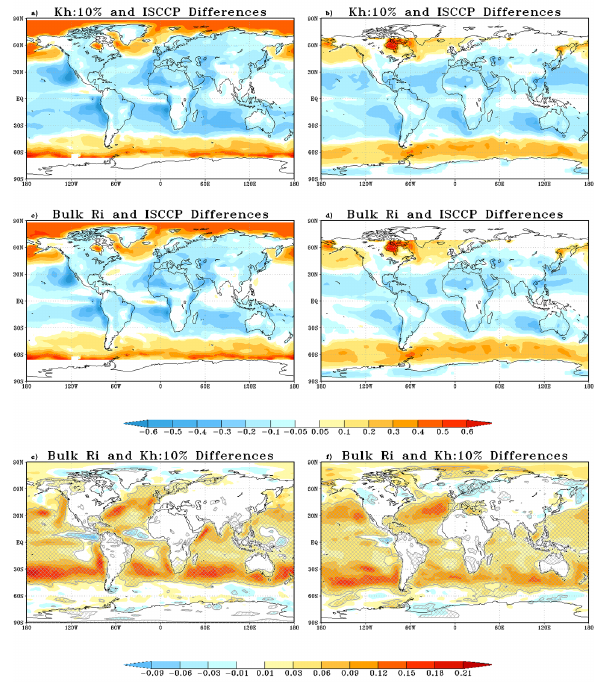
Figure 11. Seasonal mean low-level cloud fraction differences. Method 2 minus ISCCP for JJA (a) and DJF (b) , Method 3 mi- nus ISCCP for JJA (c) and DJF (d) , and Method 3 minus Method 2 for JJA (e) and DJF (f) . Hatch marks on the bottom plots represent significance at the 90% level using the Student’s t test. Crosshatch marks represent significance at the 95%